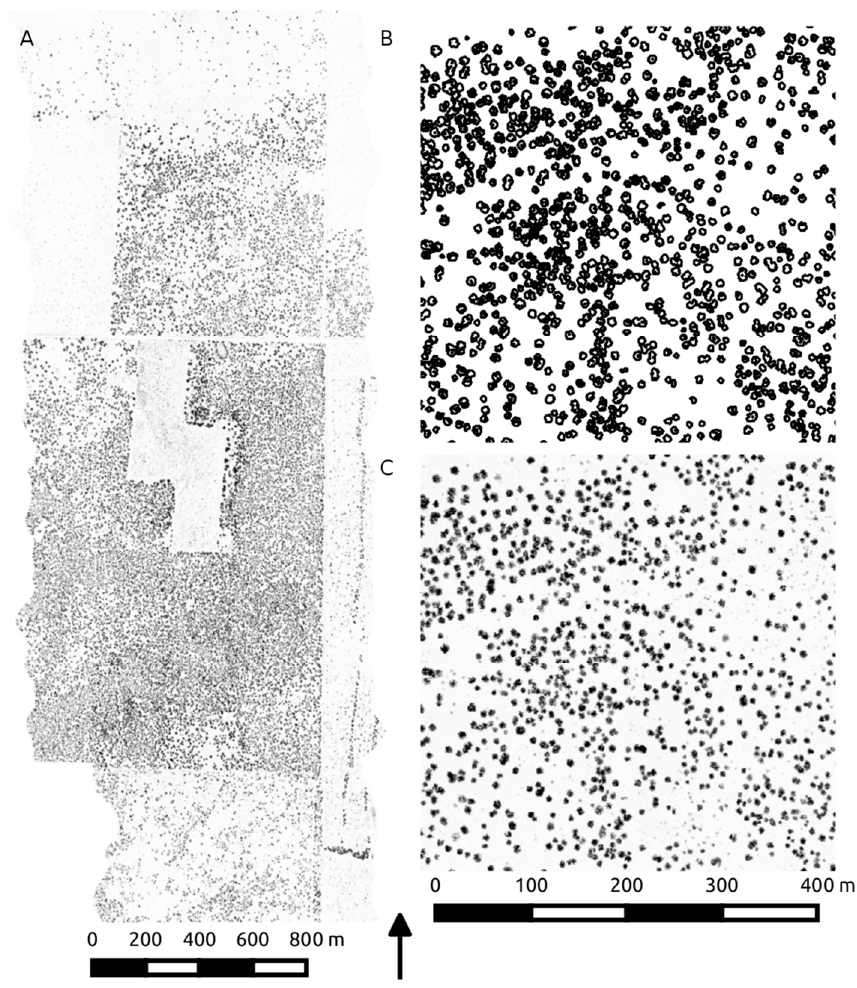
Figure 3. LiDAR canopy height acquisition extent ( A ) displayed as a canopy height raster. The corresponding TEXPERT segmentation ( B ) represents the delineated isolated and clumped crowns, used to generate canopy statistics on the raw height and volume data ( C ).